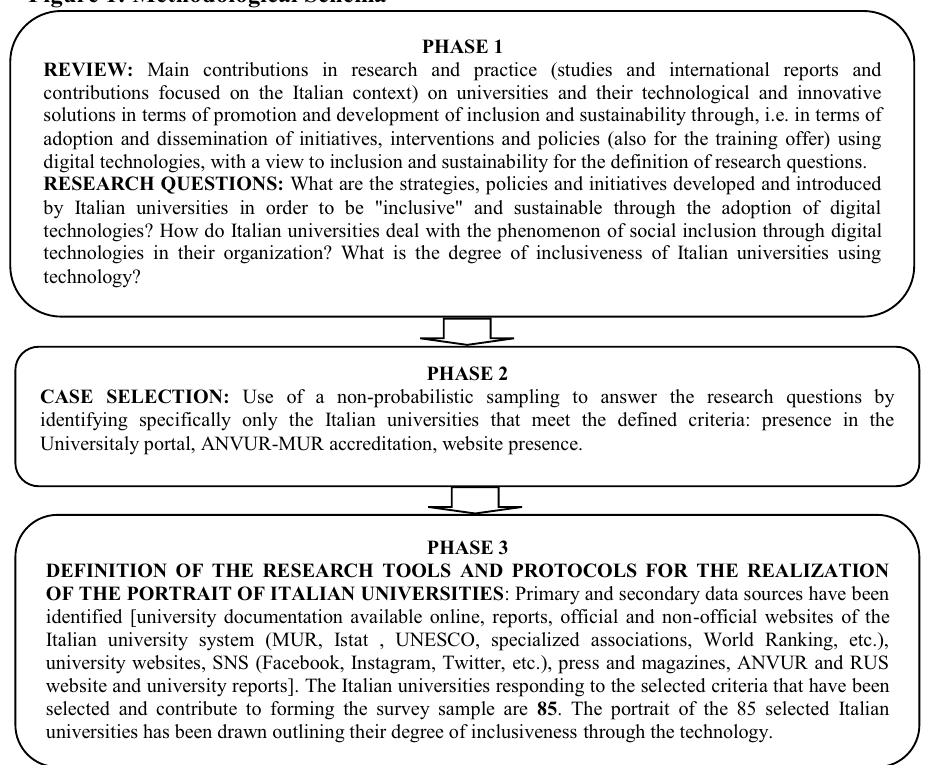
Figure 1: Methodological